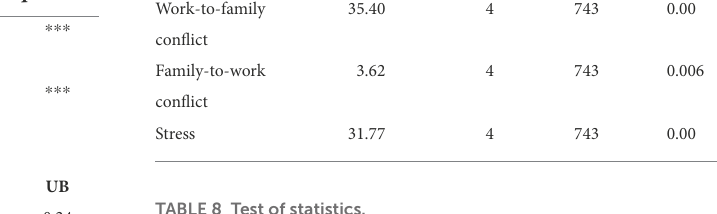
TABLE 8 Test of statistics.